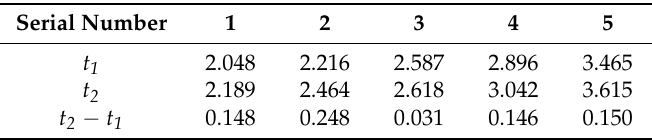
Table 4. Comparison of simulation